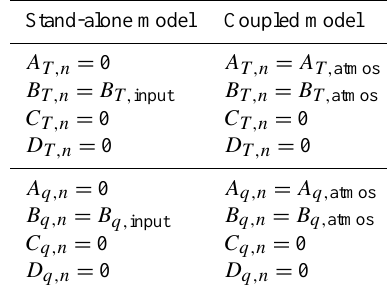
Table 2. Input coefficients at the top layer of the model, where A T,n ,B T,n ..., etc. are the respective coefficients at the top of the surface model and A T, atmos , B T, atmos are the coefficients at the lowest level of the atmospheric